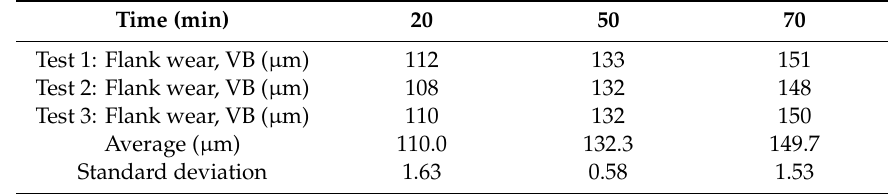
Table 4. Flank wear of Tool A.